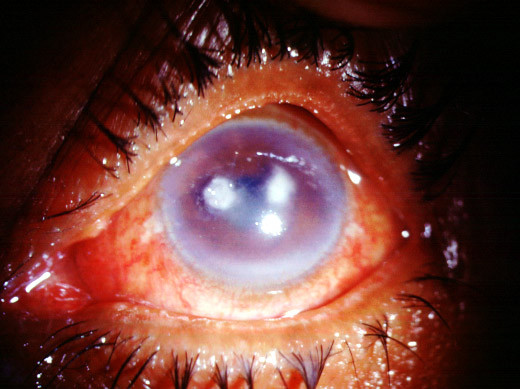
Slit lamp biomicroscopy of cornea of case 4 in diffuse illumination shows two discreet stromal infiltrates.